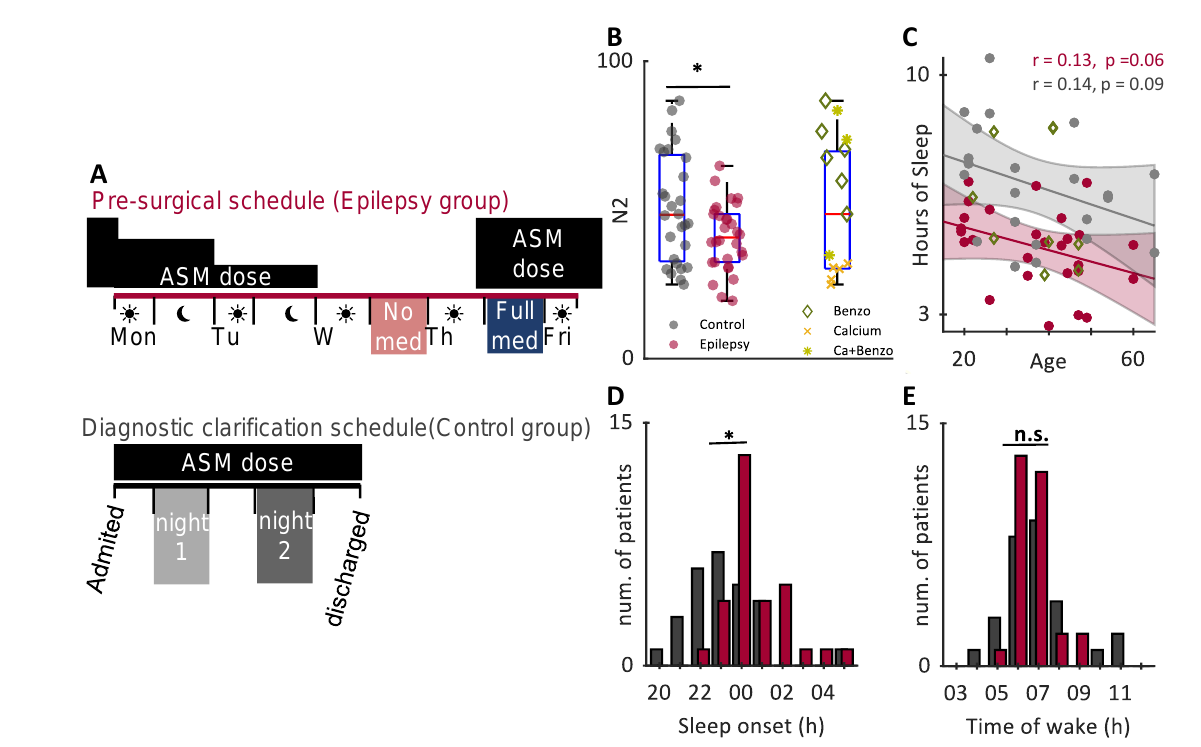
Figure 1. Differences in sleep between groups. ( A ) Cartoon showing the schedule for both the Epilepsy and Control groups. ( B ) Normalized time spent in N2 sleep between groups significantly differed between the Epilepsy and Control groups (left bars, unpaired t -test with unequal variances, p = 0.019). High variance was caused by individuals that were taking benzodiazepine (green diamonds) or Calcium modulators (yellow X) or both (light green stars). Colour code in ( B ) applies to ( C – E ). ( C ) Linear correlation of the age of participants vs. total hours slept. Points represent a single patient’s night of sleep; bands show the 95% confidence interval of linear fit. Sleep differences between groups remained significant after controlling for age and excluding benzodiazepine use (ANCOVA, Age F(1,49) = 5.9; p = 0.019, Diagnosis F(1,49) = 27.8; p < 0.001). ( D ) Histograms of sleep onset times and € wake, according to a 24 h clock. Sleep onset times were significantly later in the Epilepsy group (red) compared to Control group (grey; mean sleep onset: 1:08 for epilepsy, 23:27 for control). Wake times did not differ between group (unpaired t -test, p = 0.59) and neither sleep onset nor wake differed within group ( p > 0.05). * p < 0.05, n.s. p >